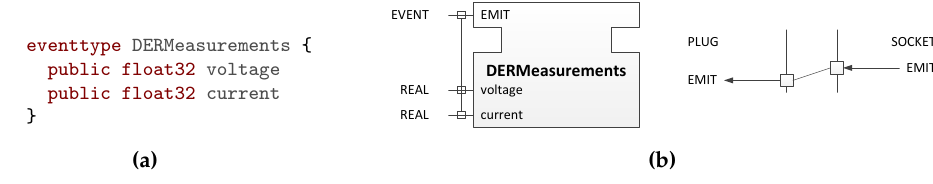
Figure 8. Illustrating example of a mapping between an <event> and an Adapter 499 : ( a ) <event> definition in PSAL; ( b ) Adapter 499 type definition in IEC 61499.